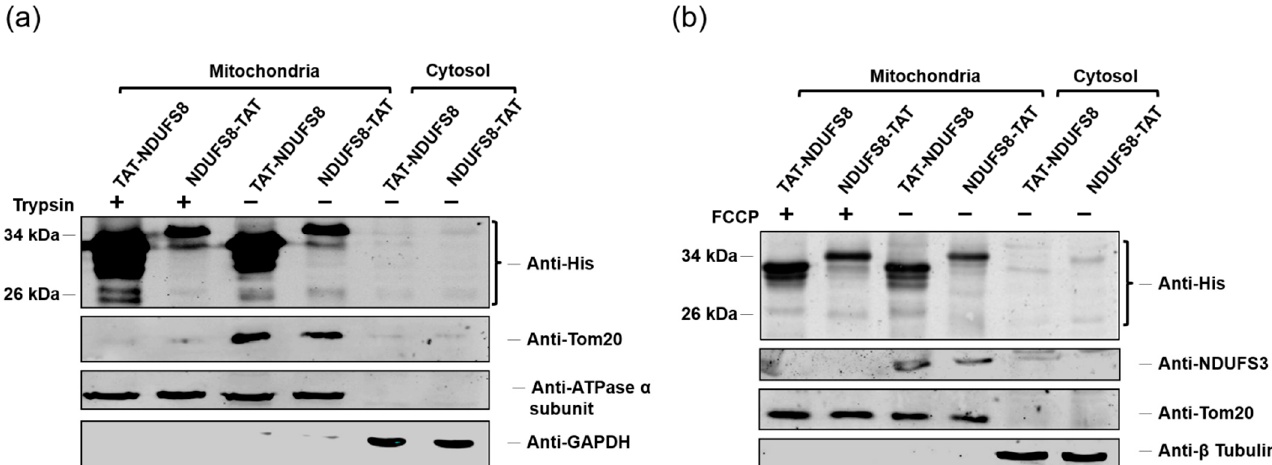
Figure 3. Transduction of exogenously produced TAT-NDUFS8 and NDUFS8-TAT across the mitochondrial inner membrane was independent of ΔΨ m. ( a ) The effects of trypsin treatment on the mitochondrial targeting and processing of TAT-NDUFS8 or NDUFS8-TAT introduced by protein transduction. After protein transduction and subcellular fractionation, the mitochondrial fractions were treated with or without trypsin. ( b ) The effects of FCCP treatment on the protein translocation of TAT-NDUFS8 or NDUFS8-TAT across the mitochondrial inner membrane. Cells were cultivated with or without FCCP for 18 h, followed by protein transduction with TAT-NDUFS8 or NDUFS8-TAT for another 3 h. ( a , b ) After subcellular fractionation, immunoblotting analysis was performed. The His-tagged fusion proteins were detected with anti-His antibody. The protein markers of the obtained fractions were detected with specific antibodies to verify the correct subcellular fractionation and used as the loading controls: β -tubulin and GAPDH were used as cytosolic markers; ATPase α subunit was used as an inner mitochondrial membrane marker; Tom20 was used as an outer mitochondrial membrane marker; NDUFS3 was used as a mitochondrial matrix marker.